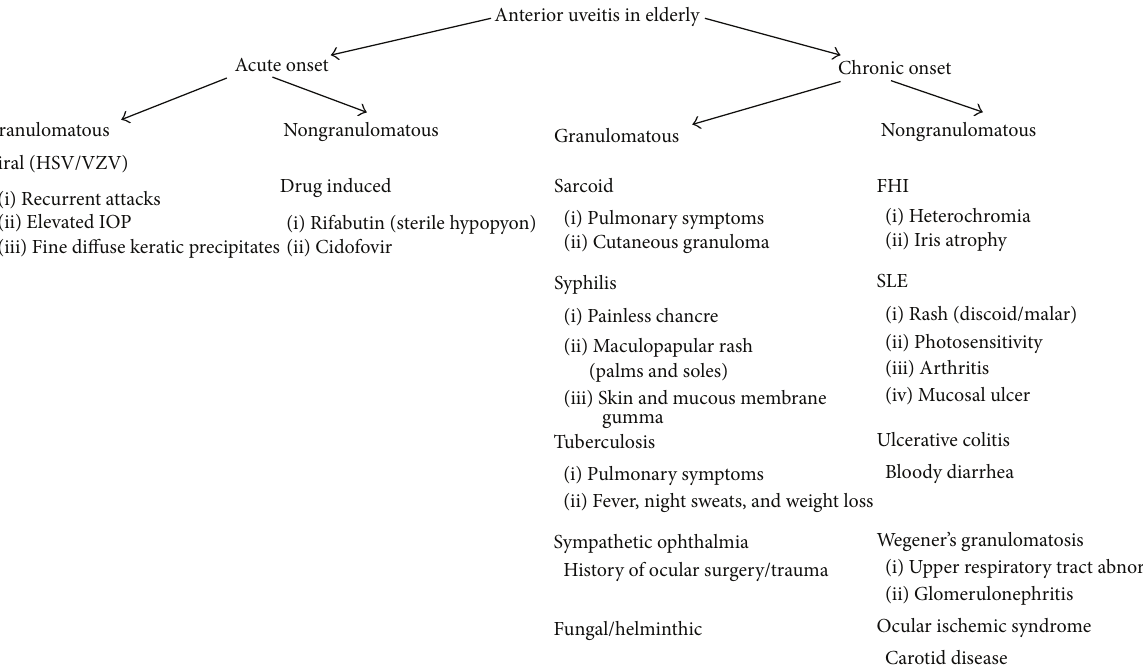
Figure 1: Differential diagnosis of anterior uveitis in elderly patients. HSV: Herpes Simplex virus. VZV: Varicella Zoster virus. VKH: Vogt Kayanagi Harada syndrome. FHI: Fuch’s heterochromic iridocyclitis. SLE: Systemic Lupus Erythematosus.